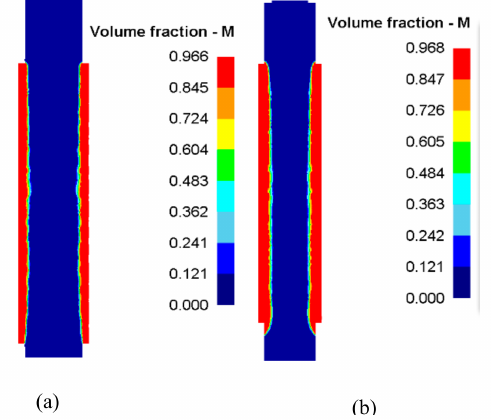
Figure 5. Simulated martensitic hardened layer under ( a ) the conventional and ( b ) optimized processes.